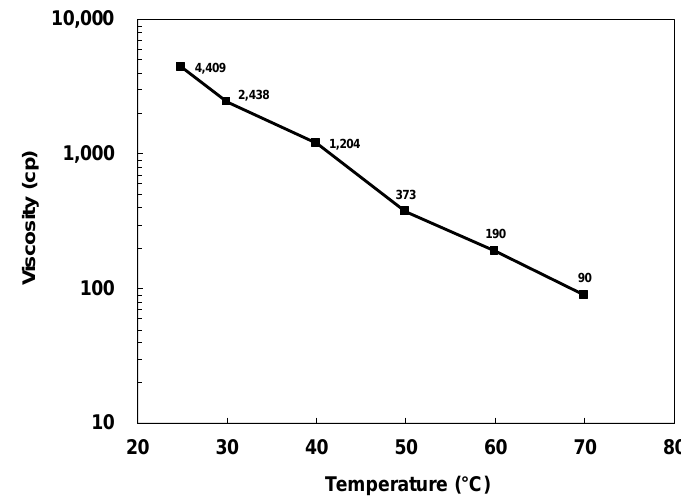
Figure 4. Viscosity of bio-crude oil and ethanol blend (BCO90) at various temperatures.